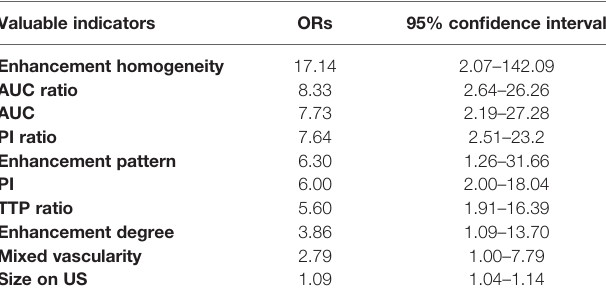
TABLE 5 | Valuable indicators on US and the odds ratios